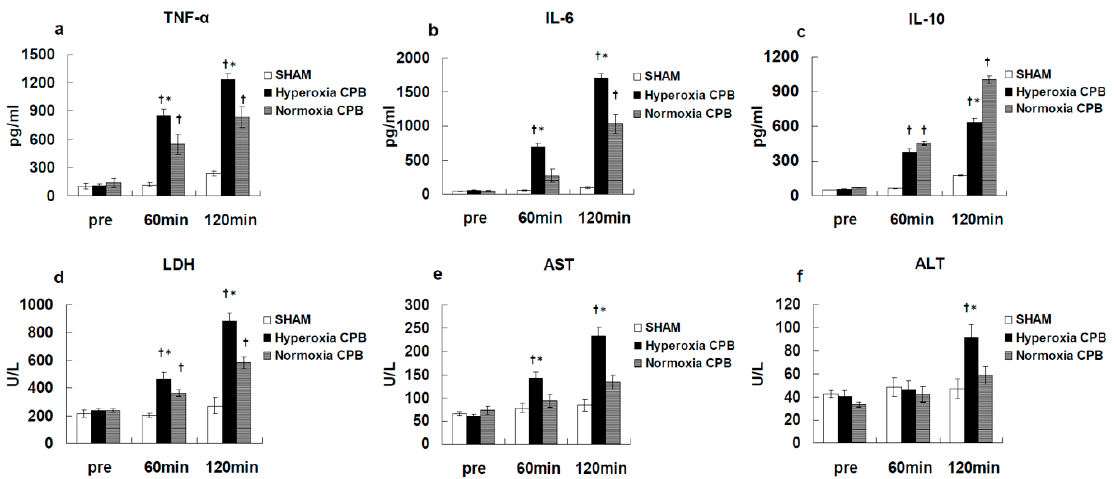
Figure 3. Plasma levels of tumor necrosis factor (TNF)- α ( a ), interleukin (IL)-6 ( b ), IL-10 ( c ), lactate dehydrogenase (LDH) ( d ), aspartate aminotransferase (AST) ( e ), alanine aminotransferase (ALT) ( f ) [25]. † p < 0.05 versus the SHAM group, * p < 0.05 versus the Normoxia CPB group at the same point in time.